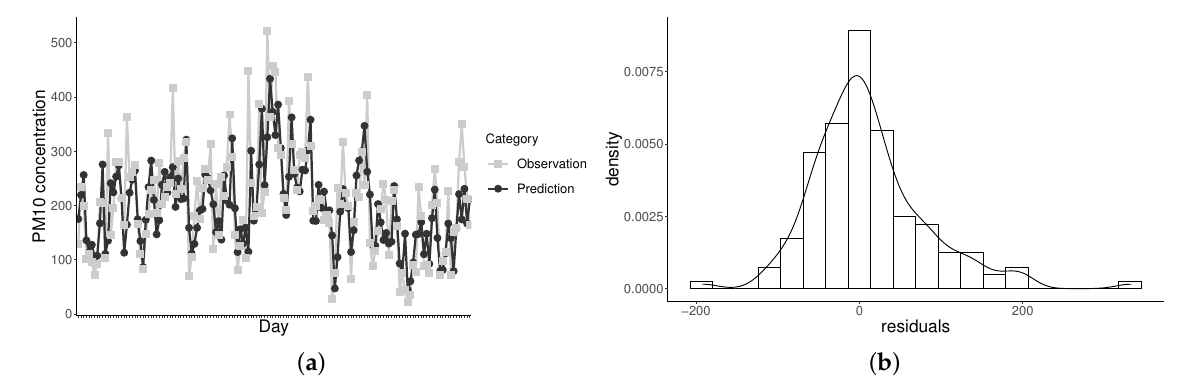
Figure 8. Predicted versus observed PM10 levels ( a ) and residual histogram ( b ) for the BS- t model with Chilean PM